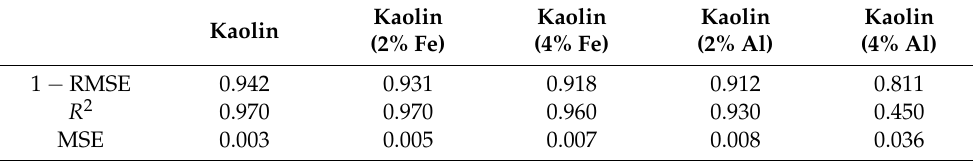
Table 5. SVM regression similarity measurements of FR using parameters of clay soil samples.